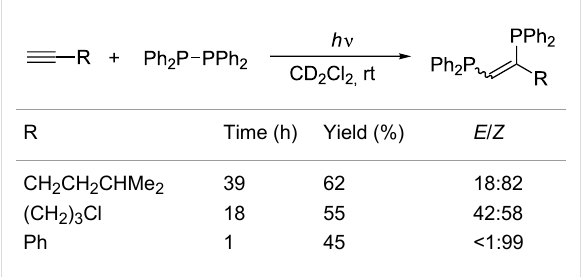
Table 2: Photoinduced radical diphosphination of terminal